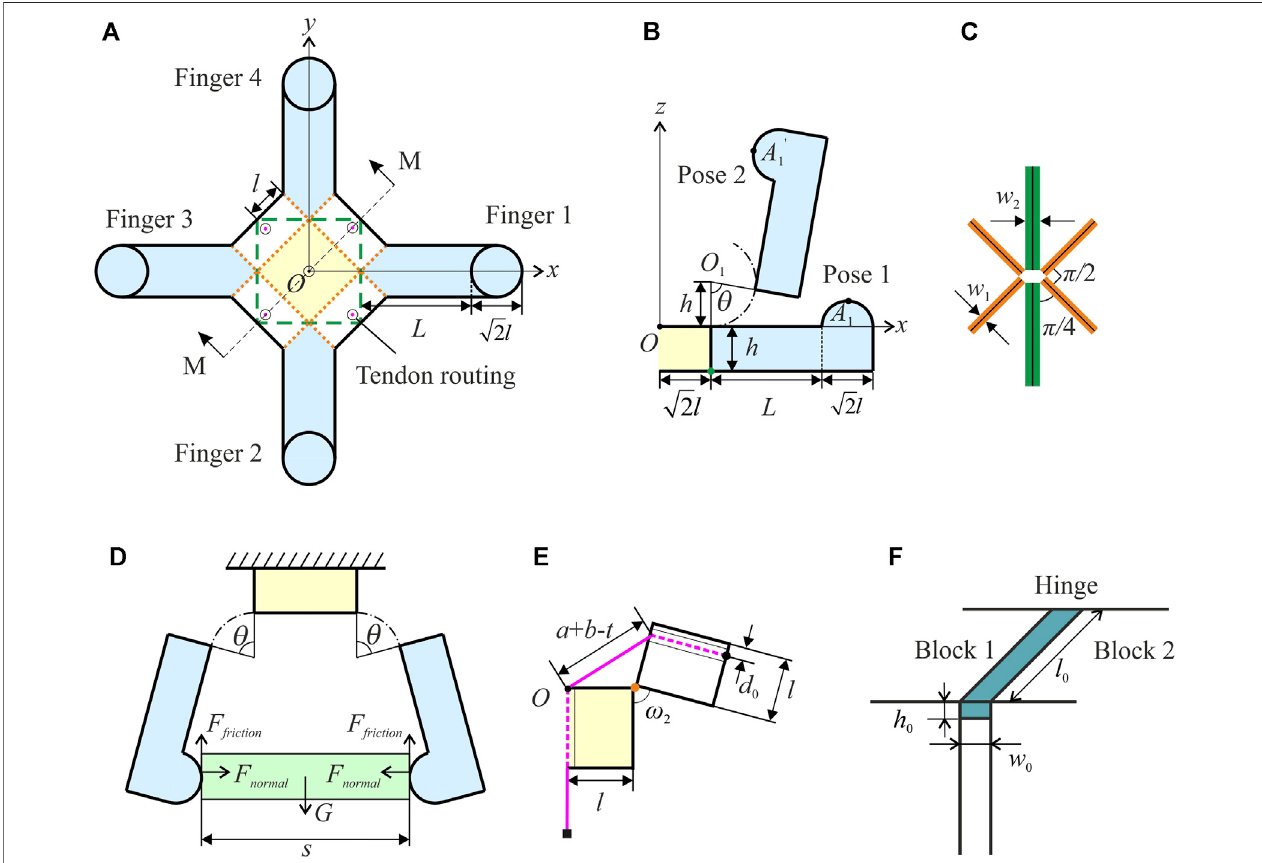
FIGURE4| Kinematicsofthegripper. (A) Proposeddesignoftheorigamigripperinthe xOy plane.Lengthened fi ngers, fi ngertips,tendonroutings,andfoldinglines arealsodenoted. (B) Finger1 ’ scross-sectionalviewalongthe x axisattwoposes.Theclosingangle θ representsthegripper ’ sstateandthetrajectoryofavertexonthe fi nger is depicted using the dot-dash line. (C) Details of a vertex where six folding lines meet. The folds ’ widths are taken into account and the middle black lines are the new folding creases used tocalculatethe gripper ’ skinematics. (D) Thegripper ’ s cross-sectional viewalong the x axis inthe grasping mode. Forces applied on the object are indicated. (E) Half view of the gripper about section M-M when the gripper is semi-closed. The path of tendons is illustrated. (F) Schematic view of a generalised fold in the waterbomb origami together with the parameters to calculate its rotational stiffness.